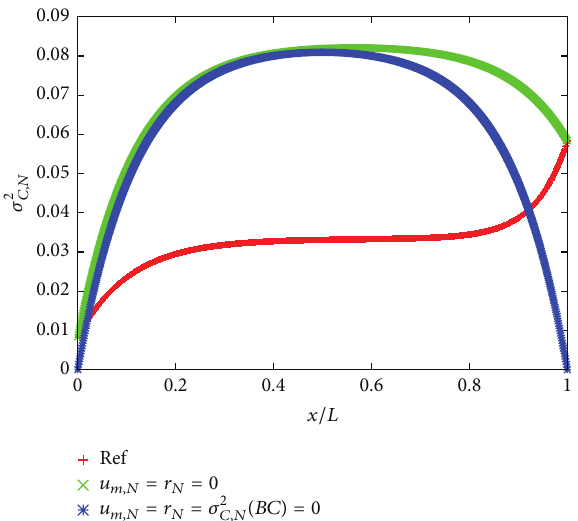
Figure 1: 1D analytical solution for the balance equation of the con- centration variance, under stationary conditions. Legend: + solution with reference parameters; × solution with reference parameters in the absence of mean velocity and 𝑟 𝑁 = 0 ; ∗ solution with reference parameters in the absence of mean velocity, null variance at boundaries, and 𝑟 𝑁 = 0